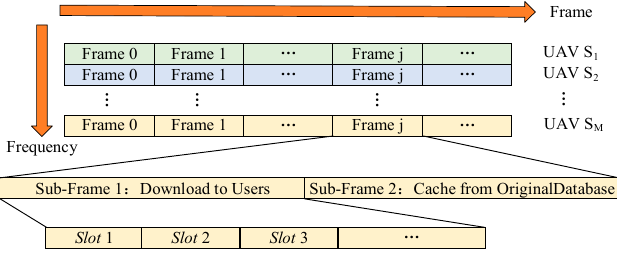
Figure 2. Frame structure of UEN.